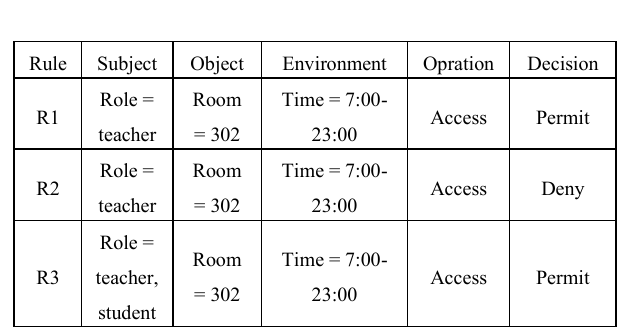
Table 2. Sample rules